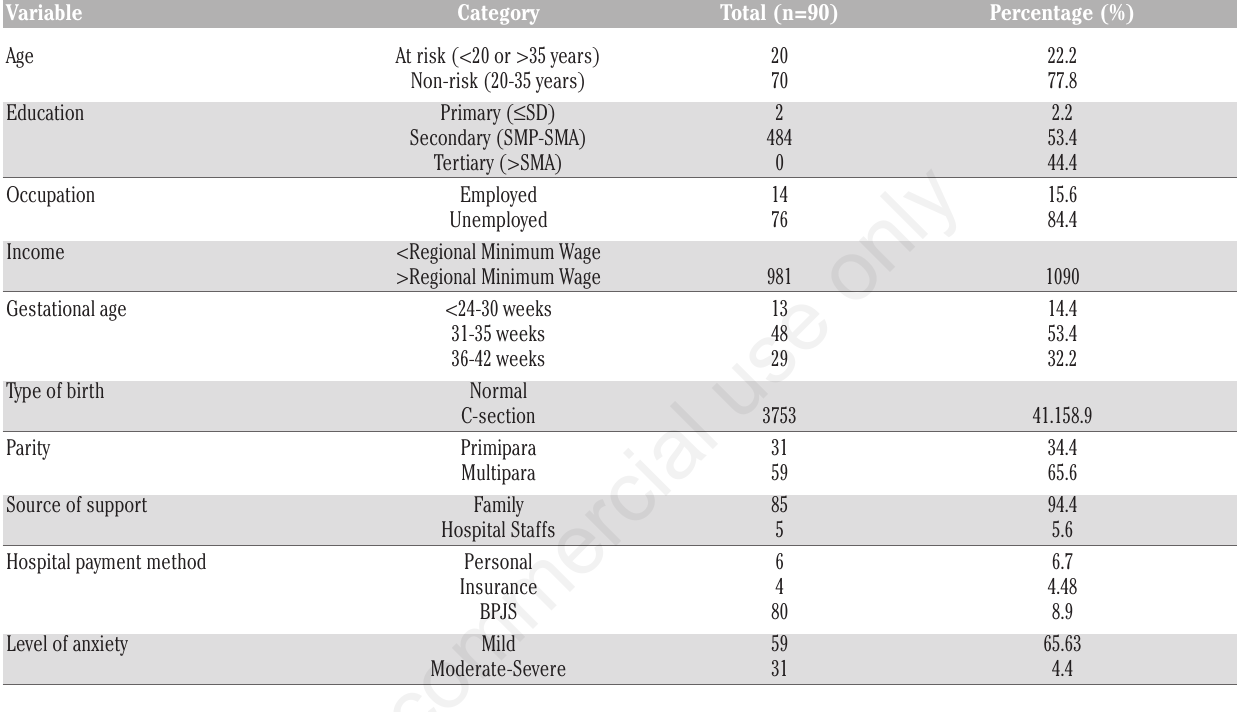
Table 1. Distribution of respondents based on the characteristics of mothers who gave birth to LBW Infants in hospital, May-June 2018 (n=90). Variable